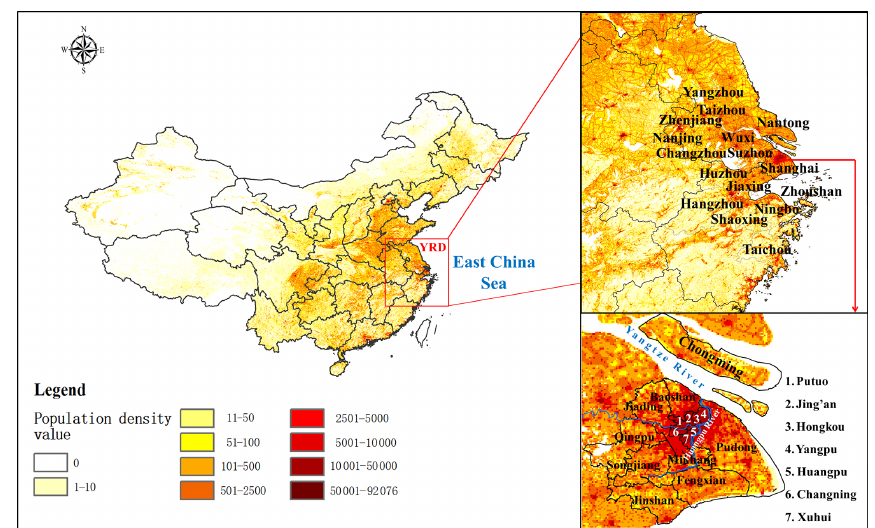
Figure 1. Geographical location of the study area YRD/Shanghai including the population density in 2015. A total of 16 core cities in the YRD and 16 administrative districts in Shanghai are noted on the map. The smaller administrative districts are labeled using numbers: Putuo (1), Jing’an (2), Hongkou (3), Yangpu (4), Huangpu (5), Changning (6) and Xuhui